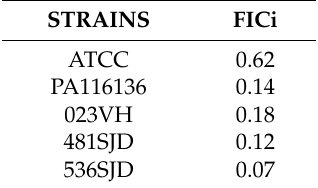
Table 2. Fractional inhibitory concentration index (FICi) values of imipenem and AMP38 combination. STRAINS FICi ATCC